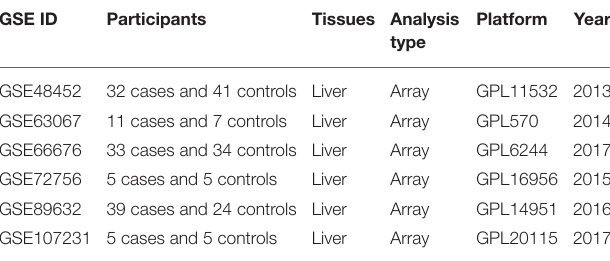
TABLE 1 | Characteristics of the included microarray